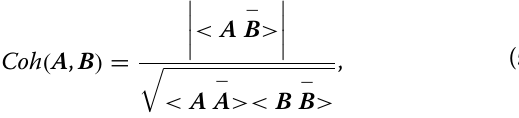
where θ i denotes the angle of the phase difference (PD) between the two spectra at a specific frequency.